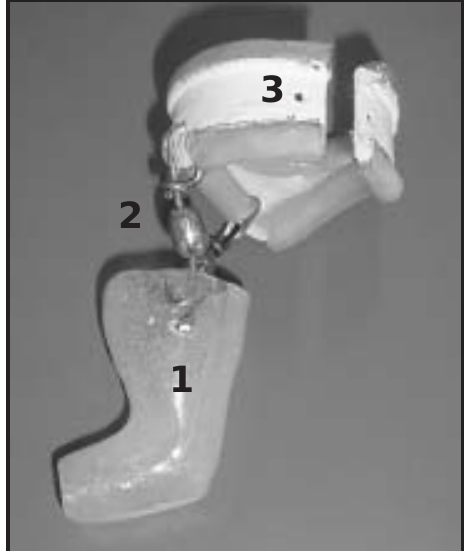
Figure 2. Orthosis in the neutral ankle position consisting of an acrylic resin model (1), lateral rotators (2) and an abdominal belt